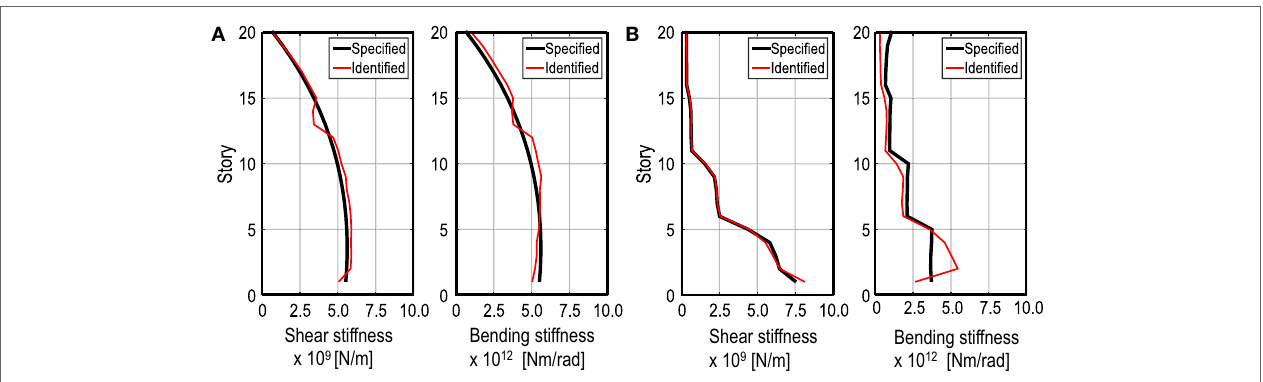
FIGURE 14 | Identification of shear and bending stiffnesses: (A) Model A and (B) Model B .